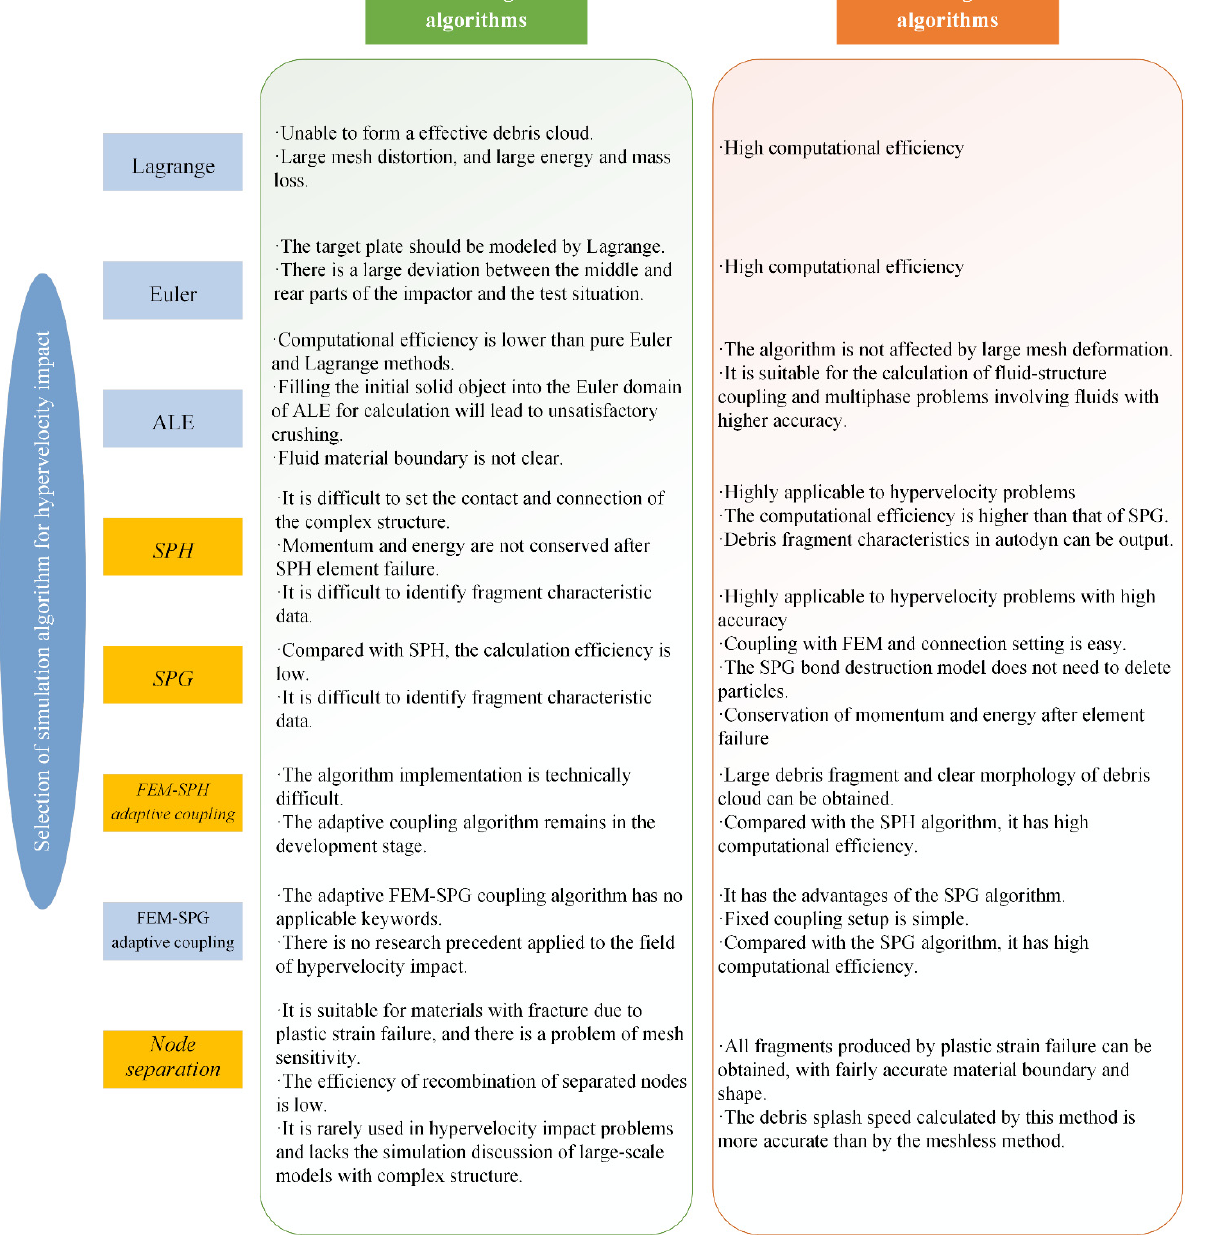
Figure 1. Advantages and disadvantages of algorithms for hypervelocity impact problems.